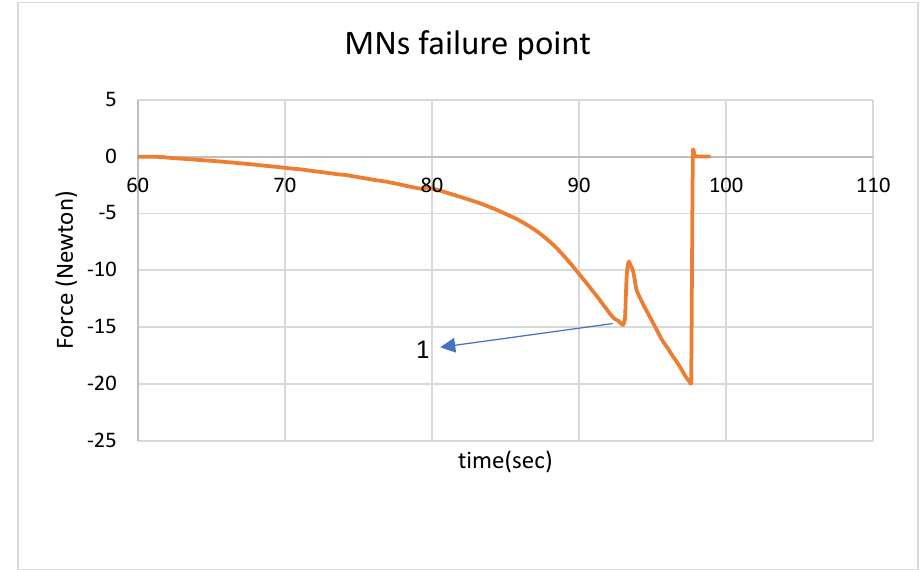
Figure 4. The load per time diagram of ElectroForce ® compression testing of a microneedle; point (1) reveals when the needle tips break. Table 1. Mechanical properties of amphotericin-B-loaded Gantrez TM polymer from nanoindentation and ElectroForce ® mechanical